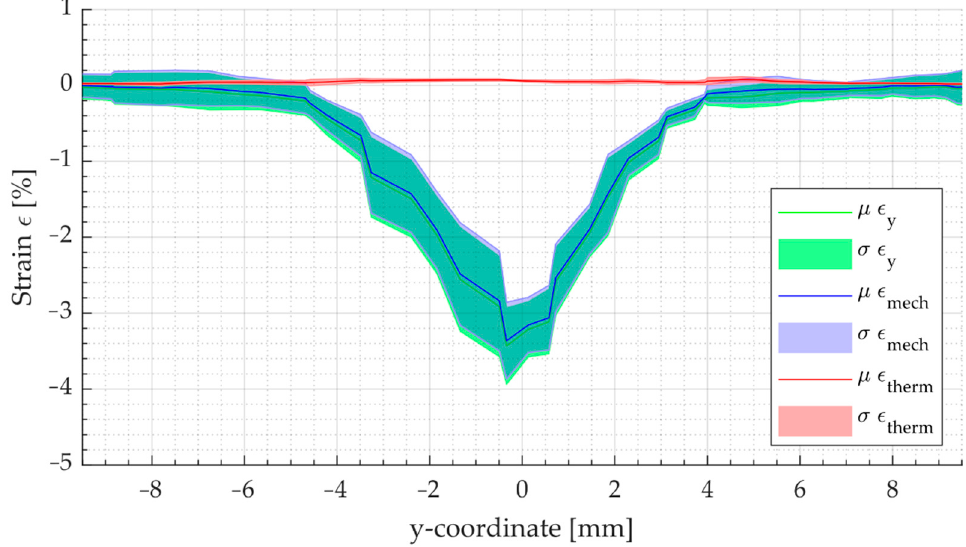
Figure 9. Plot of the mean values ( µ ) and the standard deviation ( σ ) of the total strain ε y (blue), thermal strain ε therm (red), and mechanical strain ε mech (green) for the measuring sections as a function of the y-coordinate of a TPU-0.3 specimen (test No. 9, t = 21.5 s).